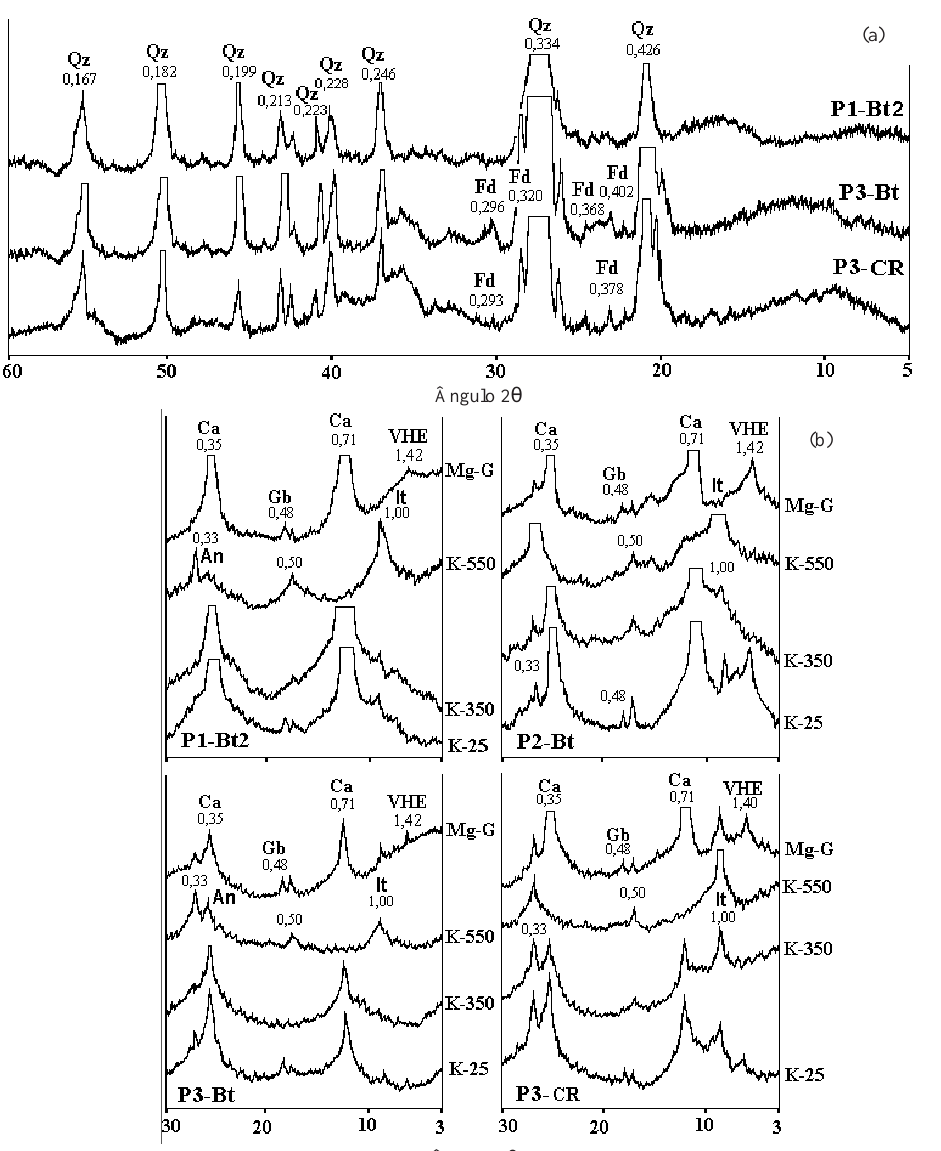
Figura 4. Difratogramas de raios-X da fração silte (a) e da fração argila (b), sendo, An = anatásio; Ca = caulinita; Fd = feldspatos; Gb = gibbsita; It = ilitas; Qz = quartzo; VHE = vermiculita com hidróxi entrecamadas (Distâncias interplanares em